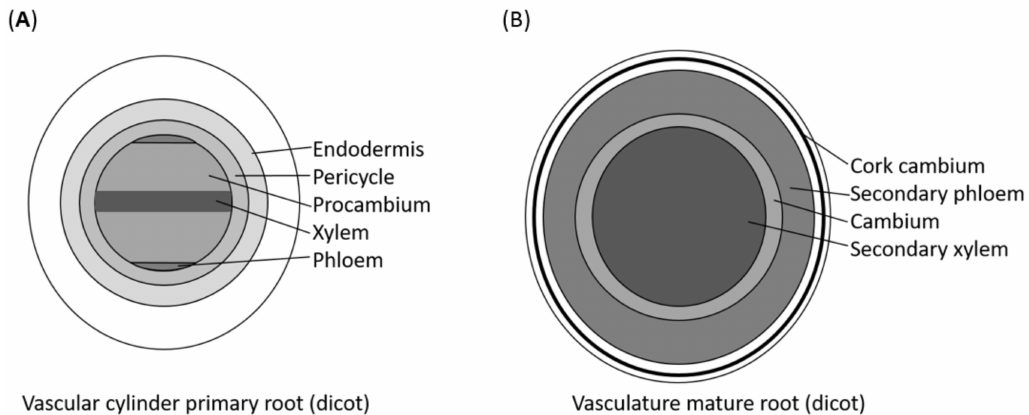
Figure 2. Schematic cross-sections of a primary root ( A ) and a mature root with secondary growth ( B ). In the primary root, two phloem poles are separated by procambium surrounding the central xylem axis. Around this structure, a ring of pericycle cells and endodermis cells can be found ( A ). In roots that have gone through secondary growth, there is a central secondary xylem cylinder surrounded by a continuous cambium and a ring of secondary phloem. Further out, a cork cambium can serve as a lateral meristem giving rise to cork and phelloderm ( B